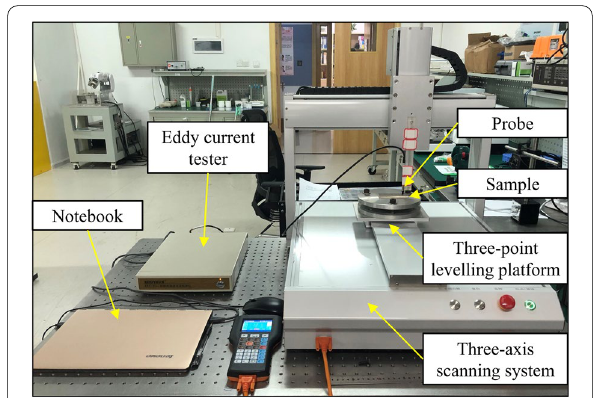
Figure 6 ECT setup used in this